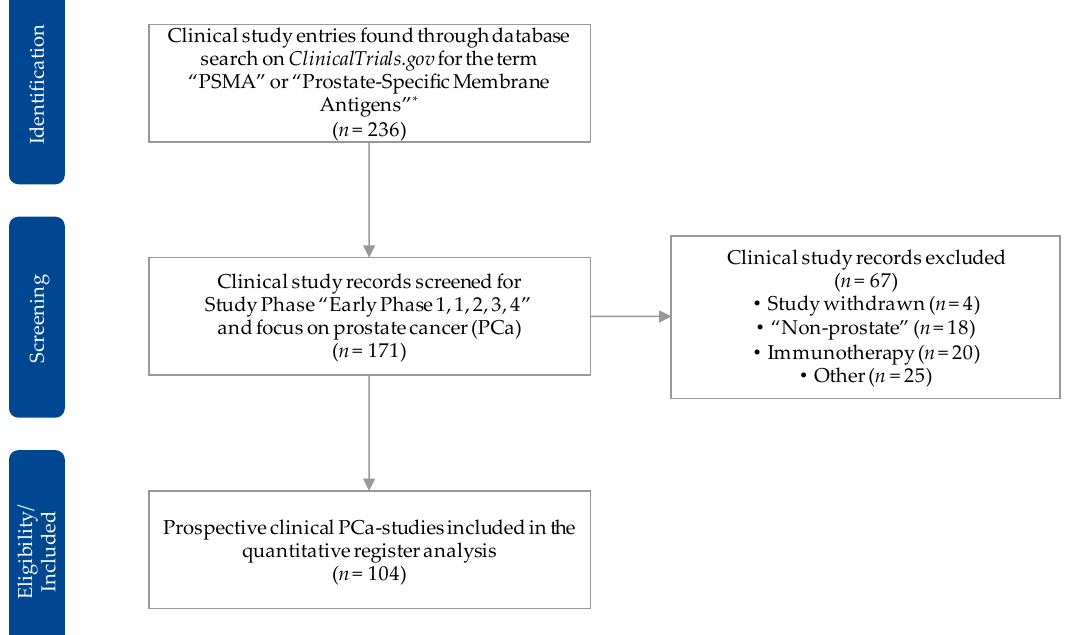
Figure 2. Flowchart for the selection procedure of the clinical study entries considered for the quantitative registry analysis. Source: Own figure based on the evaluation of the ClincalTrials.gov dataset [30].